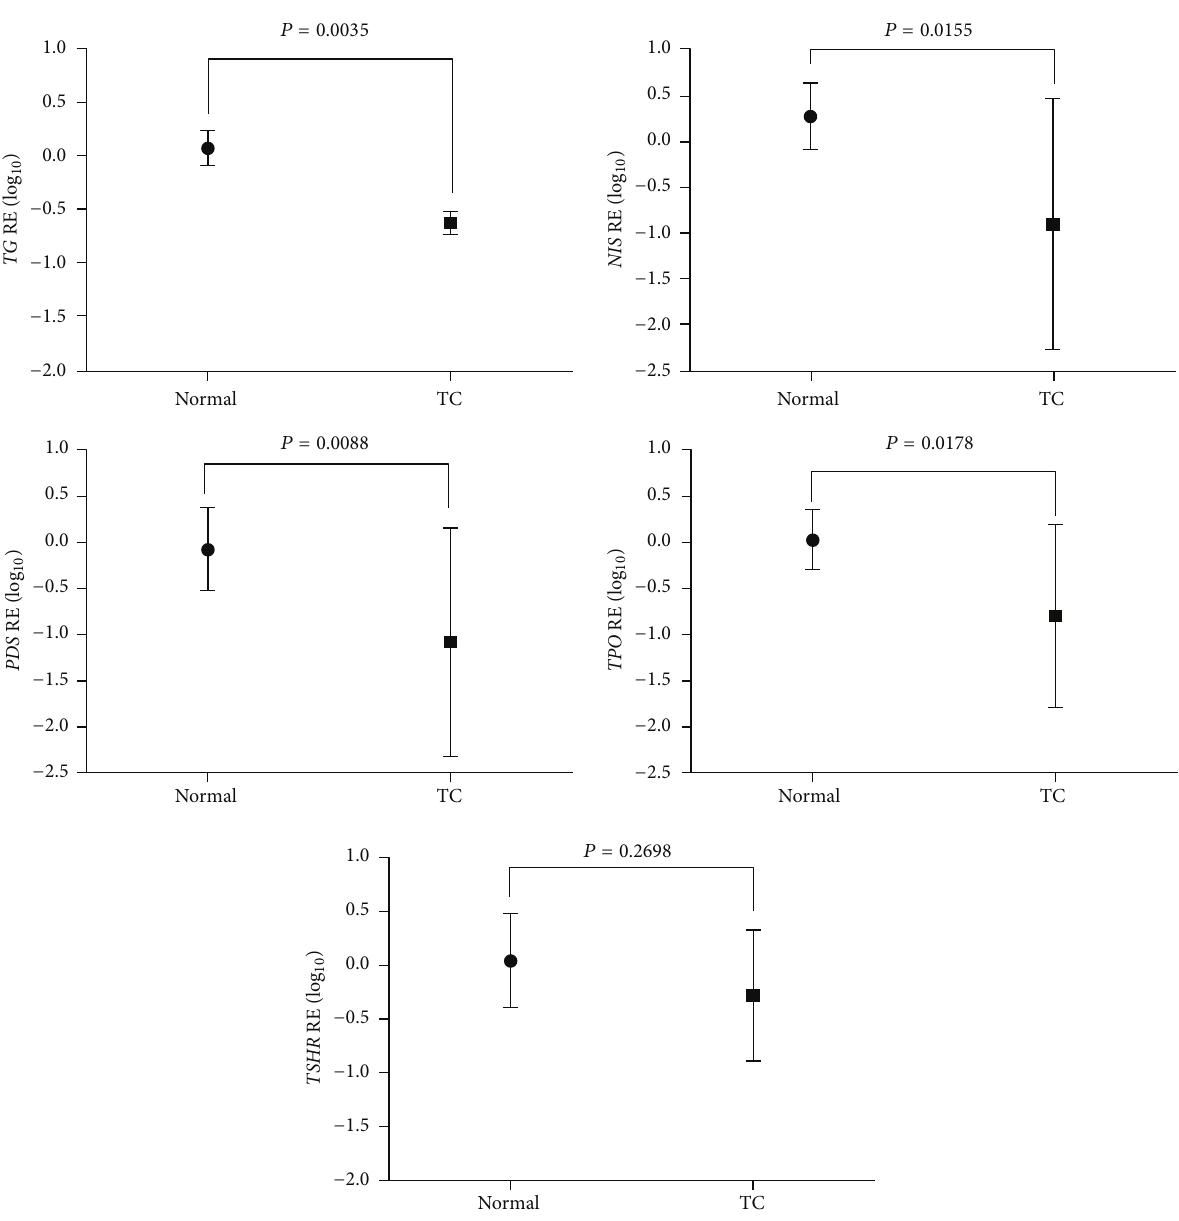
Figure 1: Relative expression (RE) of thyroid-specific genes in differentiated thyroid carcinomas (DTC) ( 𝑛 = 38 ) and normal thyroid tissues ( 𝑛 = 9 ) from pediatric patients. The graphics shows the mean value ( ± SD) of log-transformed data. 𝑃 < 0.05 were considered statistically